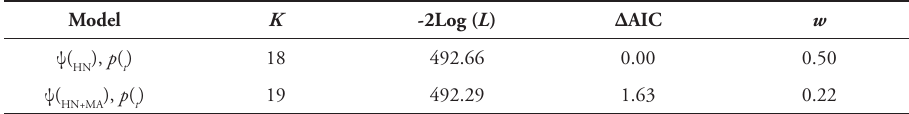
*Occupancy ( ψ ) and detection ( p ) probabilities are considered. HN = holes number; MA = microhabitats